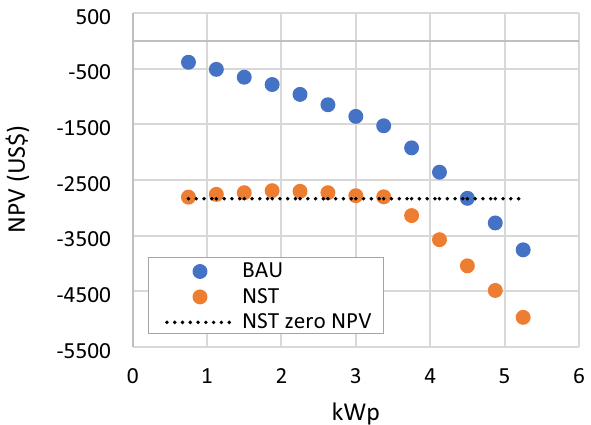
Figure 16. NPV of NST scenario compared to BAU